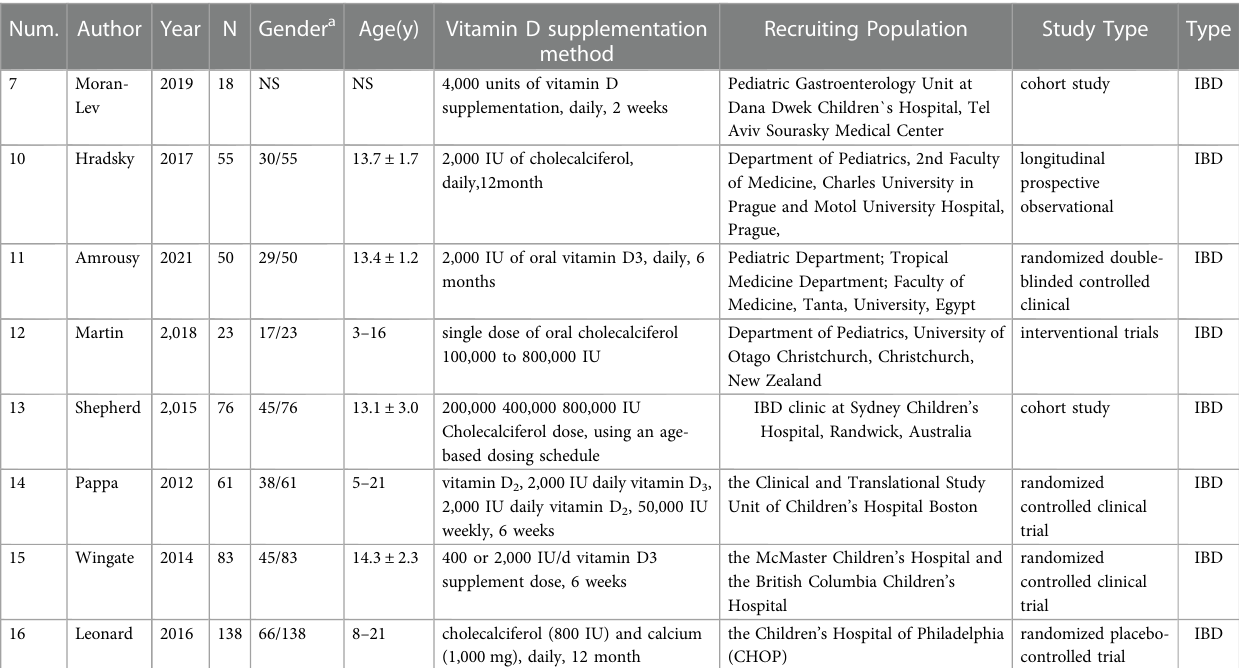
TABLE 1.2 Speci fi c information on the 7 studies about the CRP levels in IBD patients and changes in remission IBD patients before and after VD supplementation.